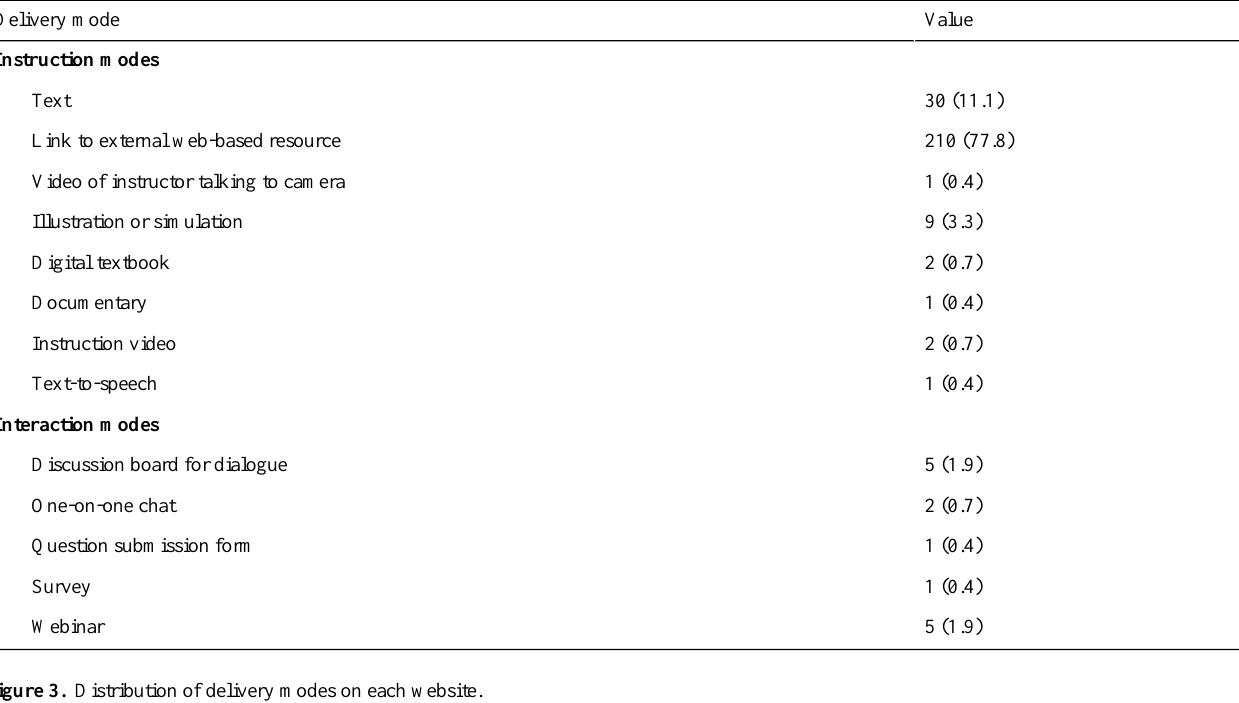
Table 1. Numbers of available delivery modes on the 14 included websites with a total of 30 webpages (N=270), n (%). No assessment modes were encountered.